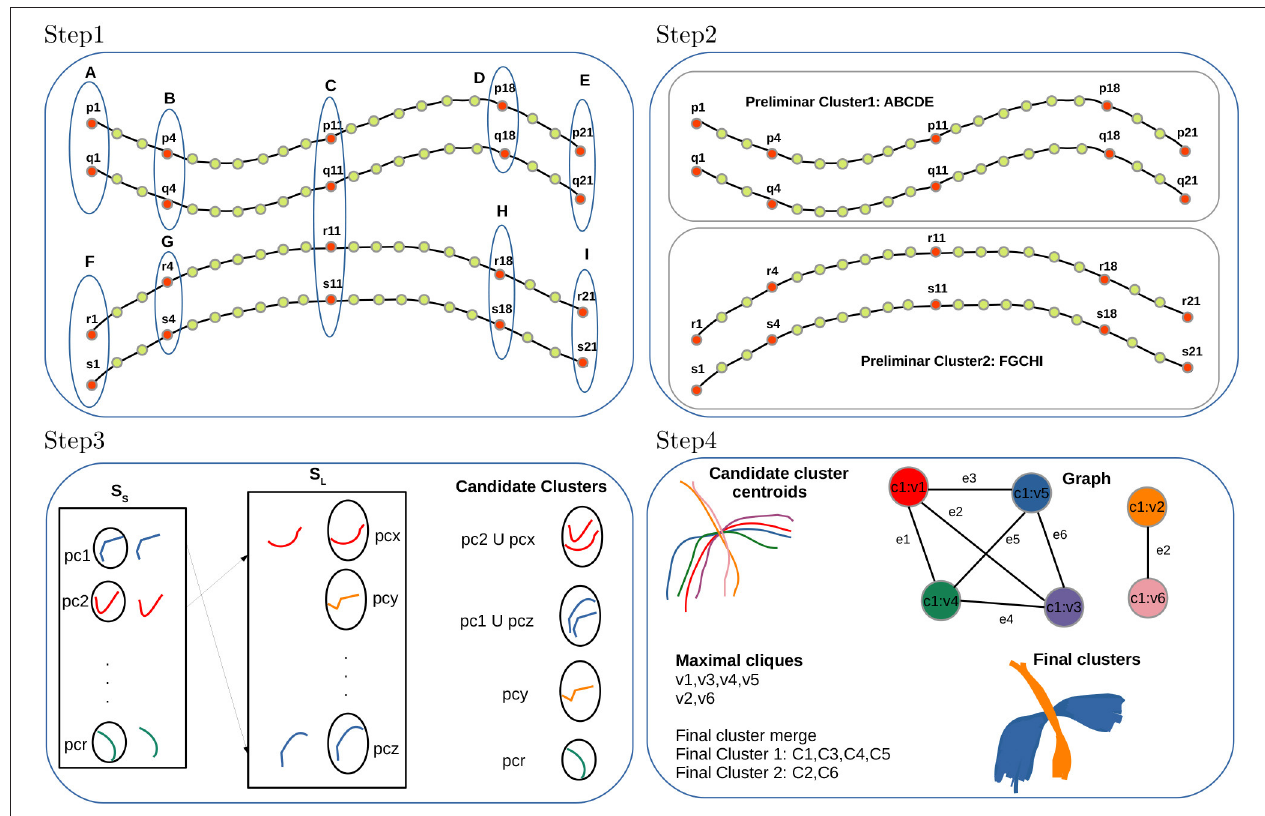
FIGURE 1 | FFClust method with its four steps. Step 1 : Building data point clusters, Step 2 : Generating preliminary fiber clusters, Step 3 : Reassignment of small to large preliminary clusters, Step 4 : Building final clusters.